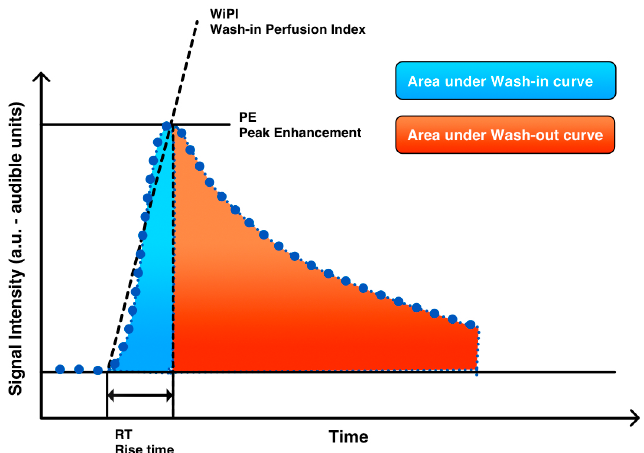
Figure 2. Fitted time-intensity curve illustrating measured parameters of peak enhancement (PE), area under the wash-in curve, area under the wash-out curve (WiAUC), wash-in perfusion index (WiPI) and rise time (RT). WiPI is WiAUC divided by RT being the interval from the beginning until peak enhancement.